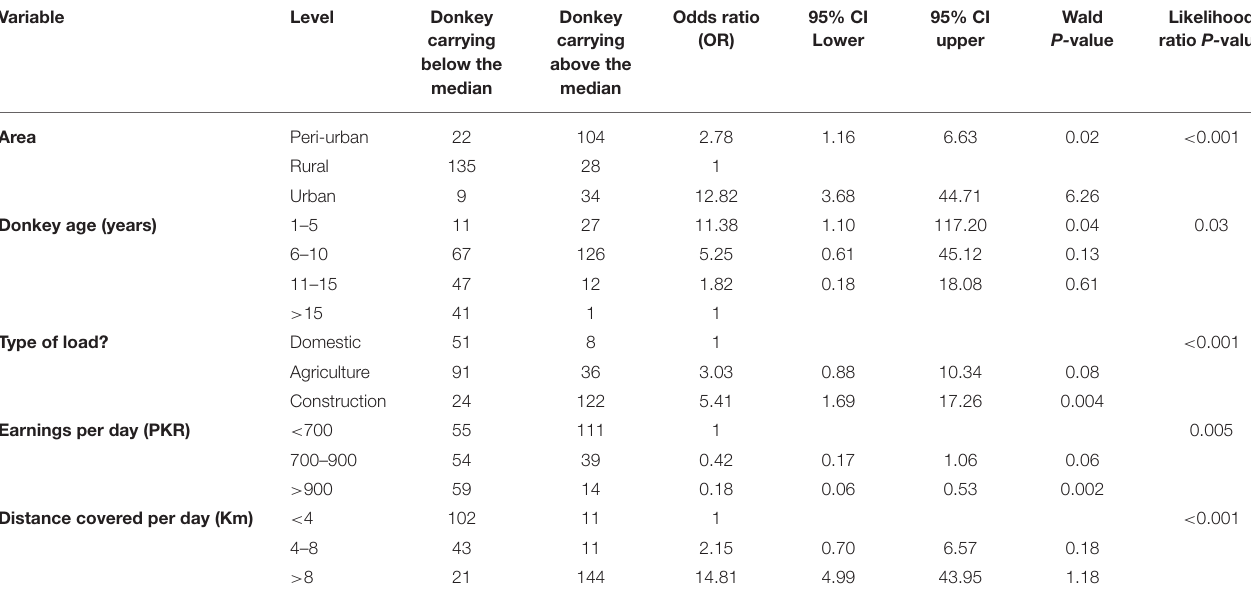
Wald Likelihood P- value ratio P- value